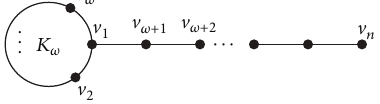
Figure 1: Kite graph 𝑃𝐾 𝑛−𝜔,𝜔 .